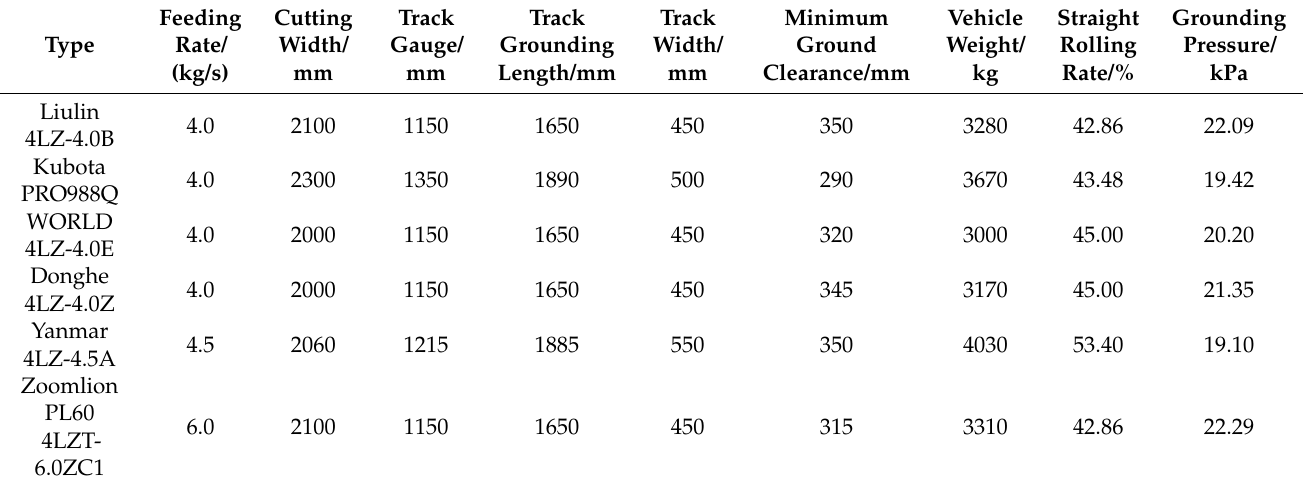
Table 1. Structural parameters of several common